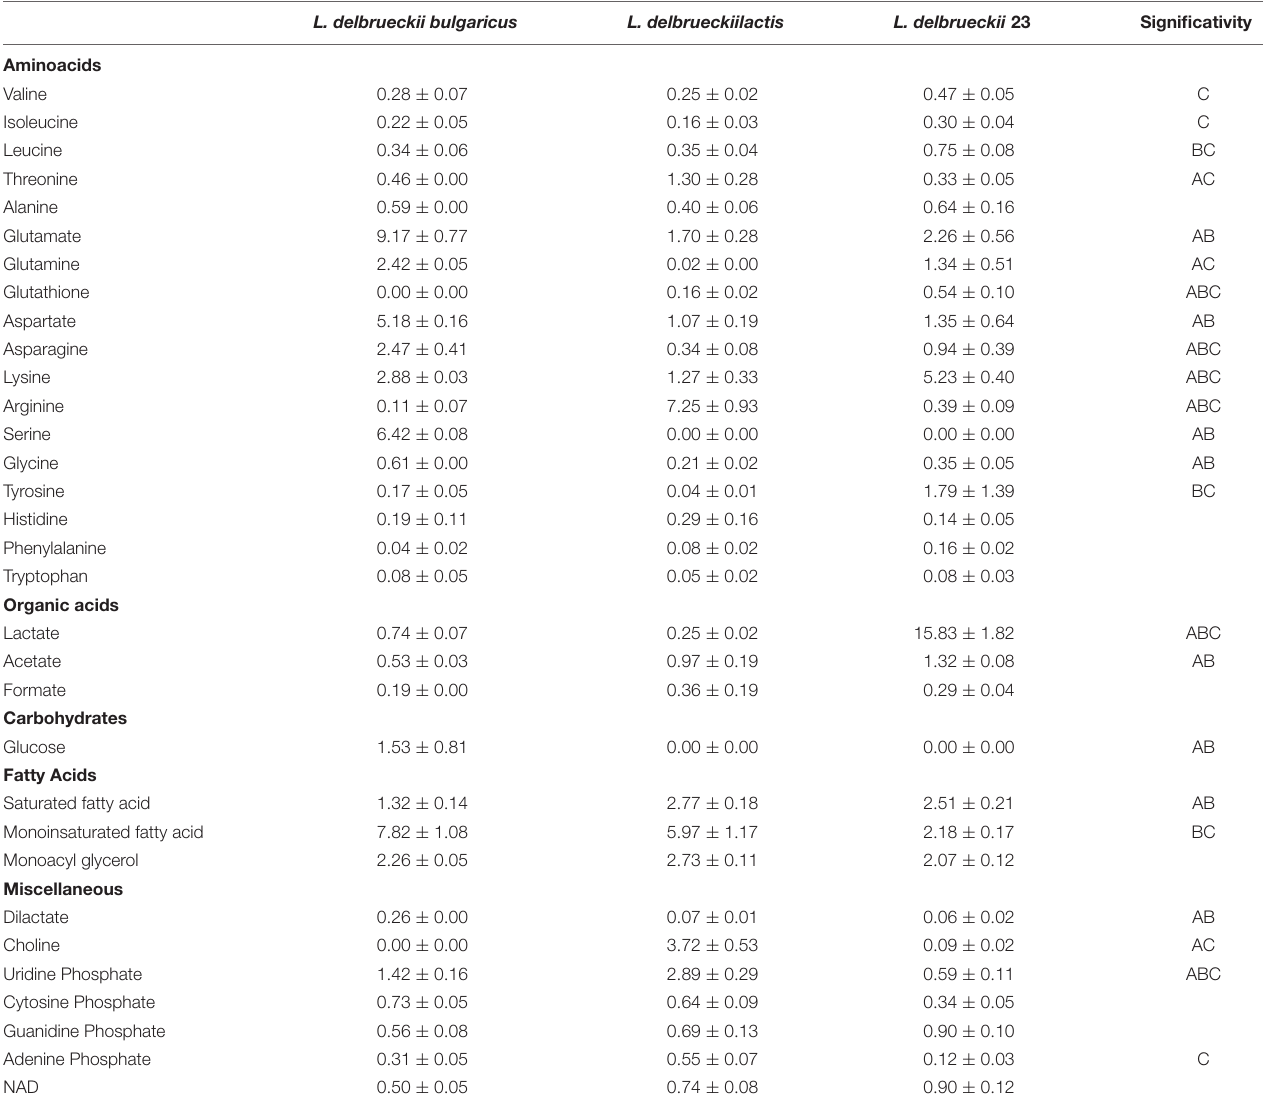
TABLE 1 | Amount of intracellular metabolites expressed as µ mol/g calculated as the average of three samples + / − standard